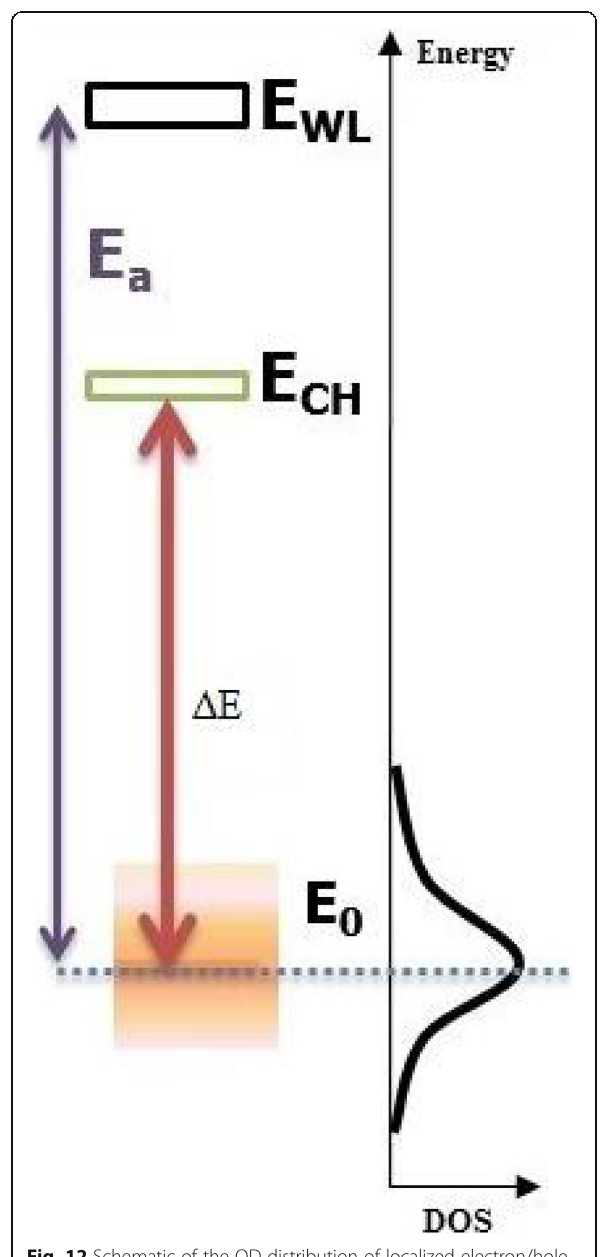
Fig. 12 Schematic of the QD distribution of localized electron/hole (exciton) states ( WL wetting layer, CH carrier transfer